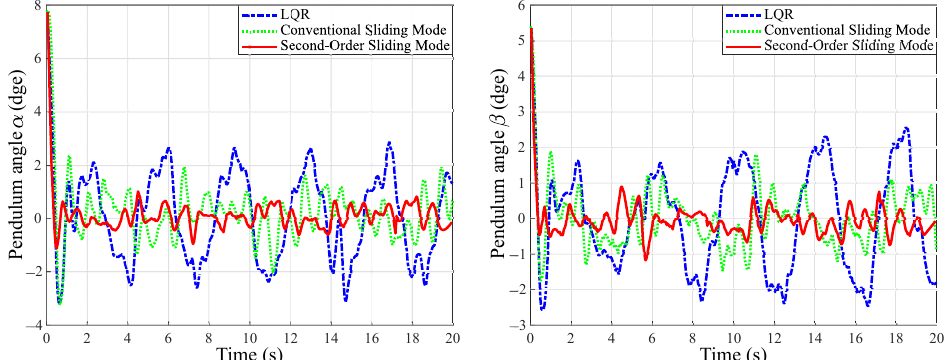
Figure 20. The experimental results compare the angle responses of the inverted pendulum on α and β , respectively.